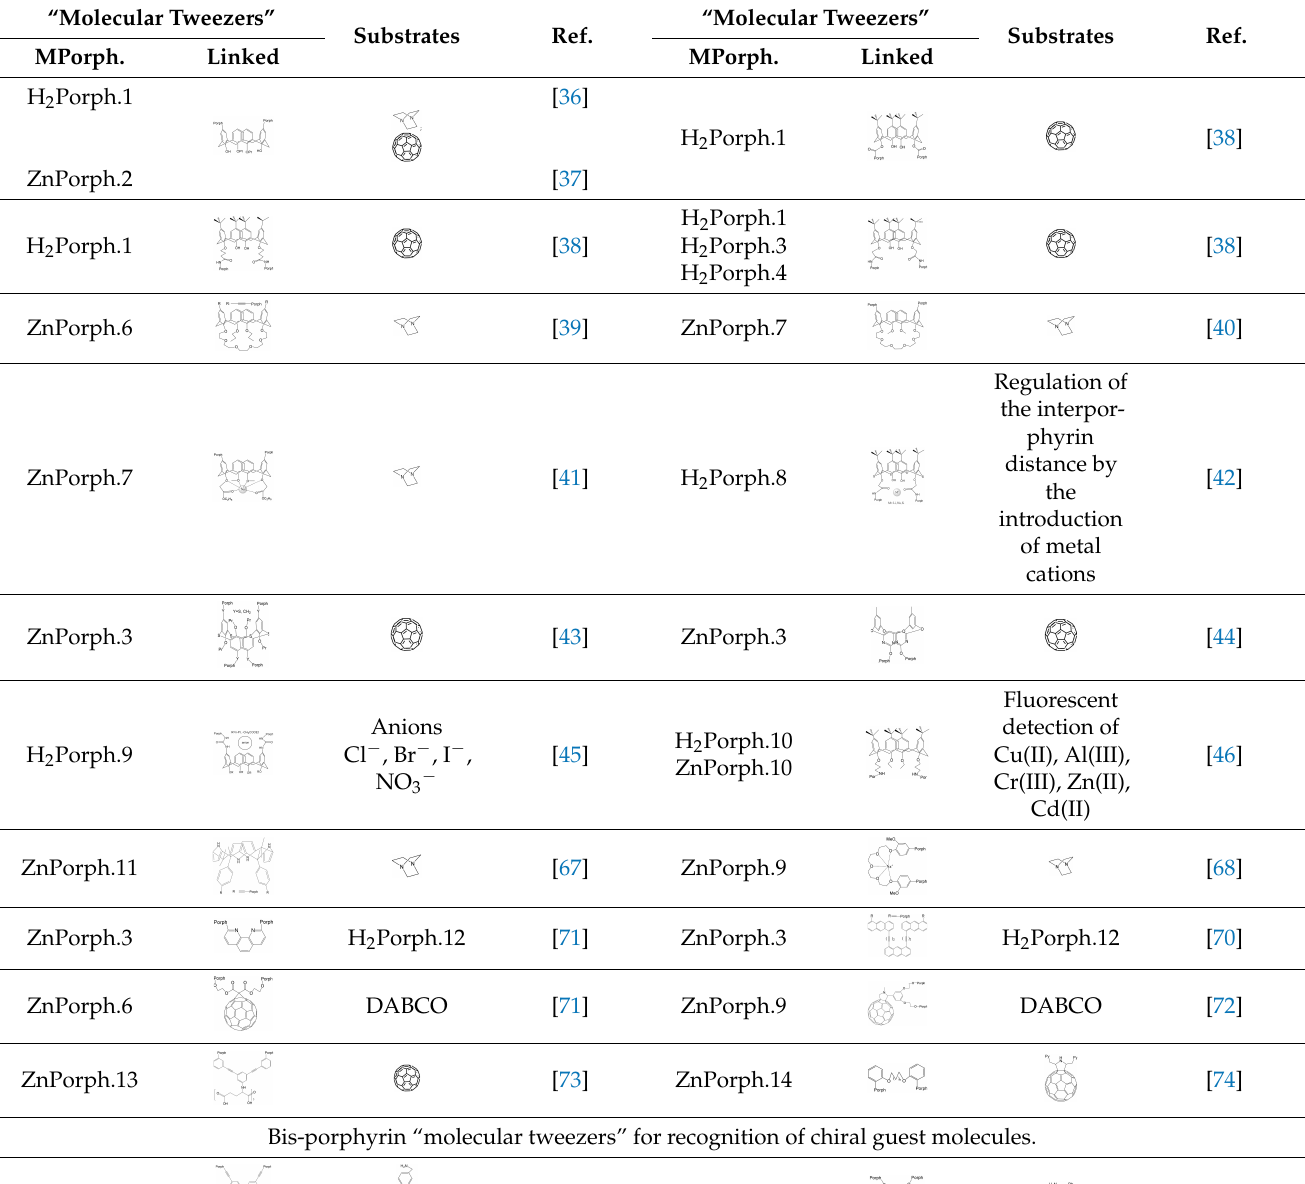
Table 1. Bis-porphyrin “molecular tweezers” for binding of substrates of different natures [36–46,67–76]. “Molecular Tweezers” “Molecular Tweezers” Substrates Ref. Substrates Ref. MPorph. Linked MPorph.